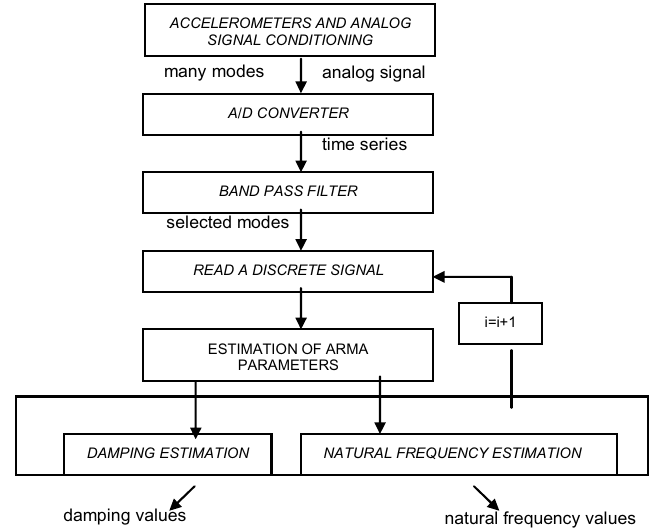
Fig. 5. Modal damping of first vibration mode obtained in experiment, compared to calculated in Matlab without wavelet filtration.